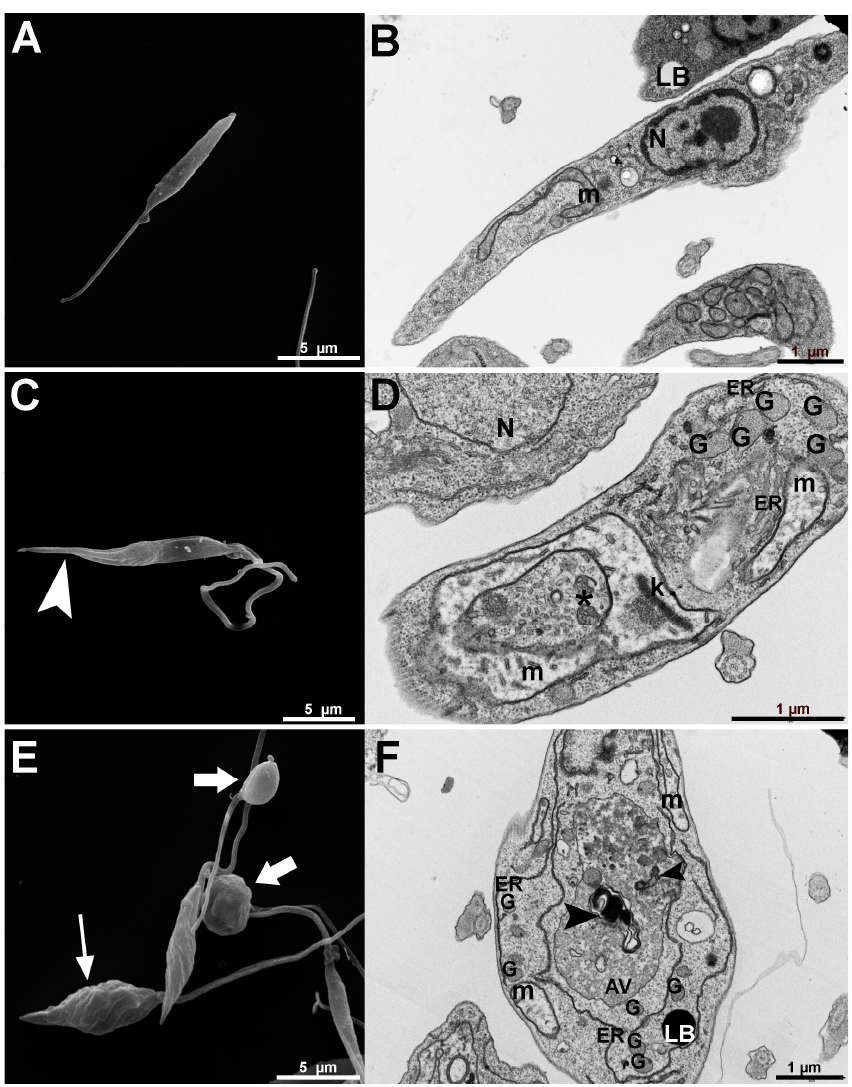
Figure 6. Scanning ( A , C , E ) and transmission ( B , D , F ) electron microscopy of Leishmania amazonensis promastigotes. ( A , B ) Control promastigote with its fusiform shape and well-preserved organelles and structures, such as mitochondria, nucleus, and lipid bodies. ( C , D ) Promastigotes treated with 3 µM H3 revealed a thinning of the posterior region of the cell body (arrowhead) and a disorder in the cytoplasm with intense vesiculation (asterisk), swelling of the mitochondrion, and loss of the mitochondrial matrix. In addition, an apparent alteration in the endoplasmic reticulum and an increased number of glycosomes were also observed. ( E , F ) Promastigotes treated with 3 µM Zn- H3 showed plasma membrane wrinkling (thin arrow) and cell body rounding (thick arrow). At the same time, ultrathin sections revealed similar alterations for Zn- H3 . In addition, the images also showed the engulfment of portions of the cytosol by the endoplasmic reticulum, resulting in the formation of autophagic vacuoles and a myelin-like fi gure (arrowhead). AV, autophagic vacuole; ER, endoplasmic reticulum; G, glycosome; k, kinetoplast; LB, lipid body; m, mitochondrion; N, nucleus.